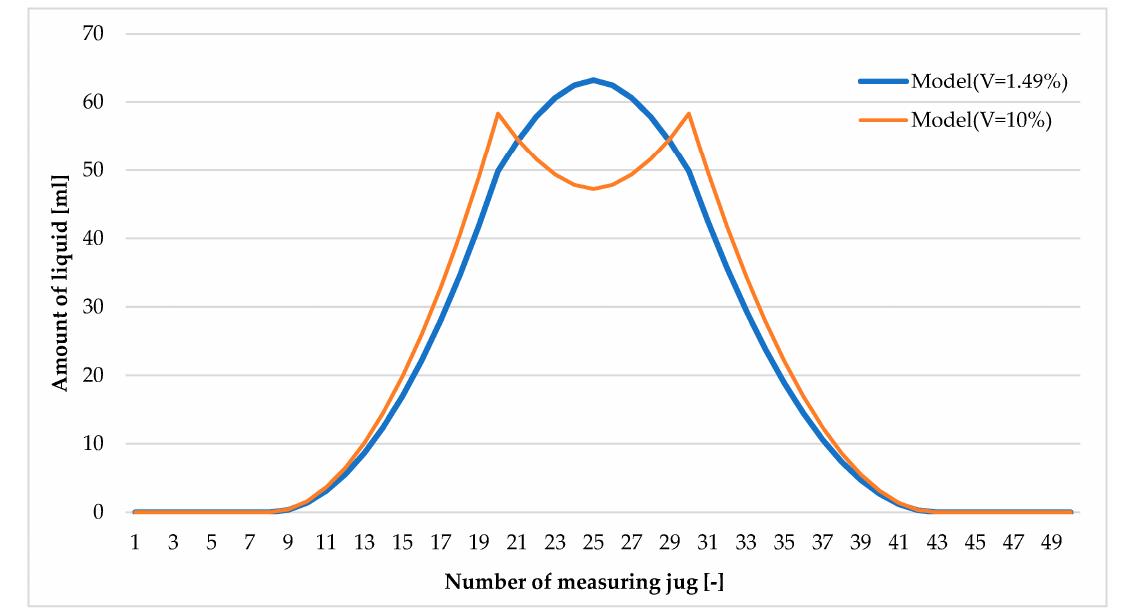
Figure 6. Spray fallout distribution for the nozzle (CV = 1.490%; CV = 10.000%)—acceptable deviation ranges.